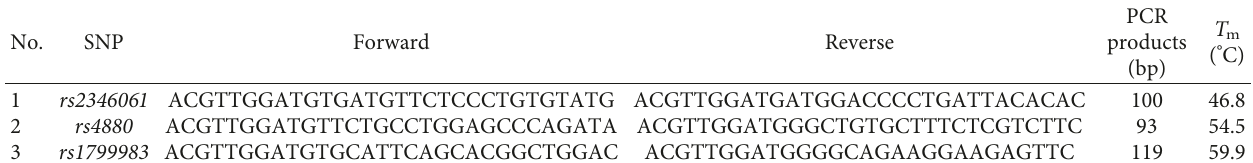
Table 2: Sequence of primers and size of the PCR products used for the genotyping.